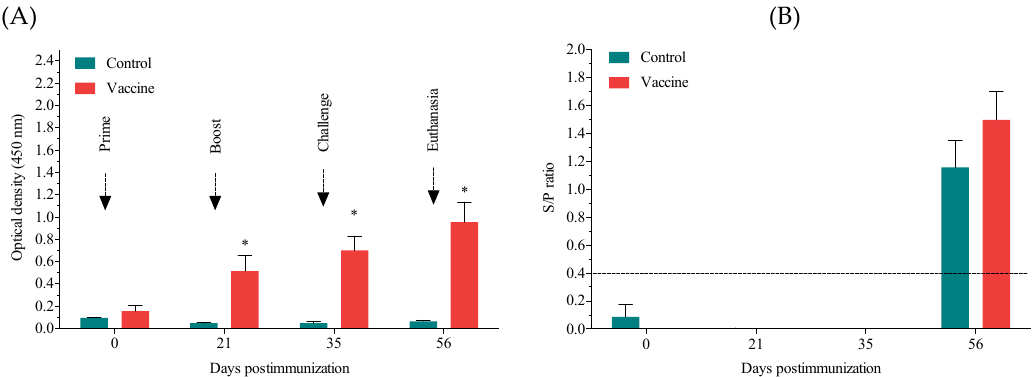
Figure 4. Antibody response to the anti-PRRSV antibody. ( A ) Evaluation of antibodies against the anti-PRRSV antibody at the beginning of the experiment (Day 0), at the time of the booster immunization (Day 21), at the time of the challenge (Day 35), and at the end of the experiment (Day 56) by ELISA. Gray bars represent the control group, and blue bars represent the vaccine group. Bars represent the mean ± standard error (SE) of three animals. ( B ) Antibody response evaluated by a commercial kit from IDEXX to confirm seroconversion in the challenged pigs.